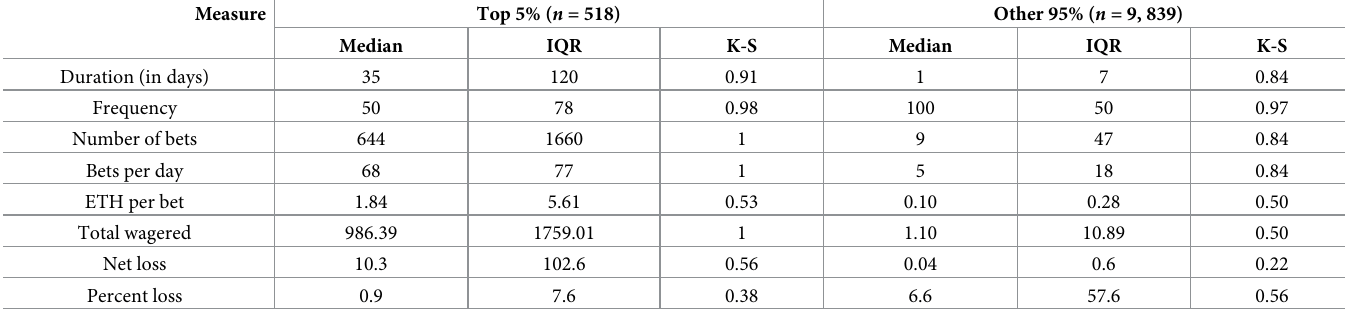
Table 6. Non-parametric descriptive statistics of the behavioural measures for the top 5% most heavily involved bettors by total amount wagered, and the other 95% of players. Measure